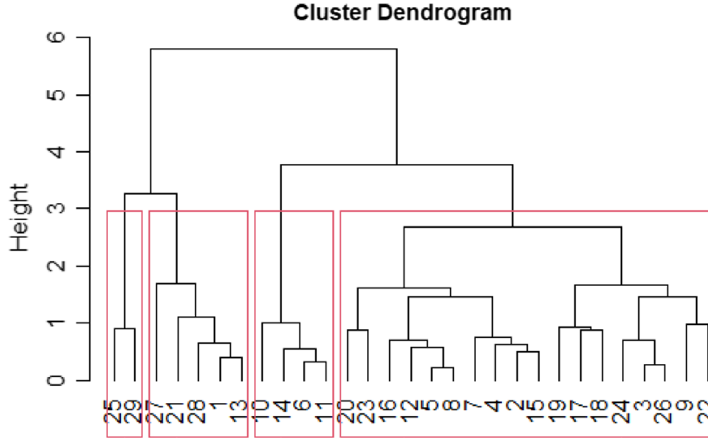
Fig. 11 Cluster dendrogram with time series correlation in stage 3